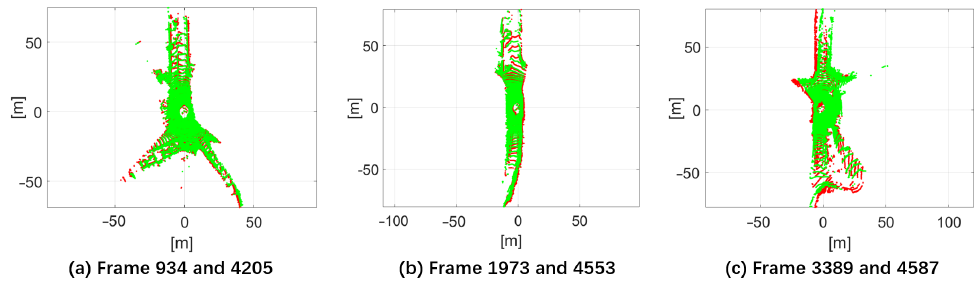
Figure 6. Overlaying two LiDAR frames in Sequence 02 according to the poses provided in the SemanticKITTI dataset. It can be seen that the pose is inaccurate, as the two scans (colored in red and green, respectively) are not well aligned.